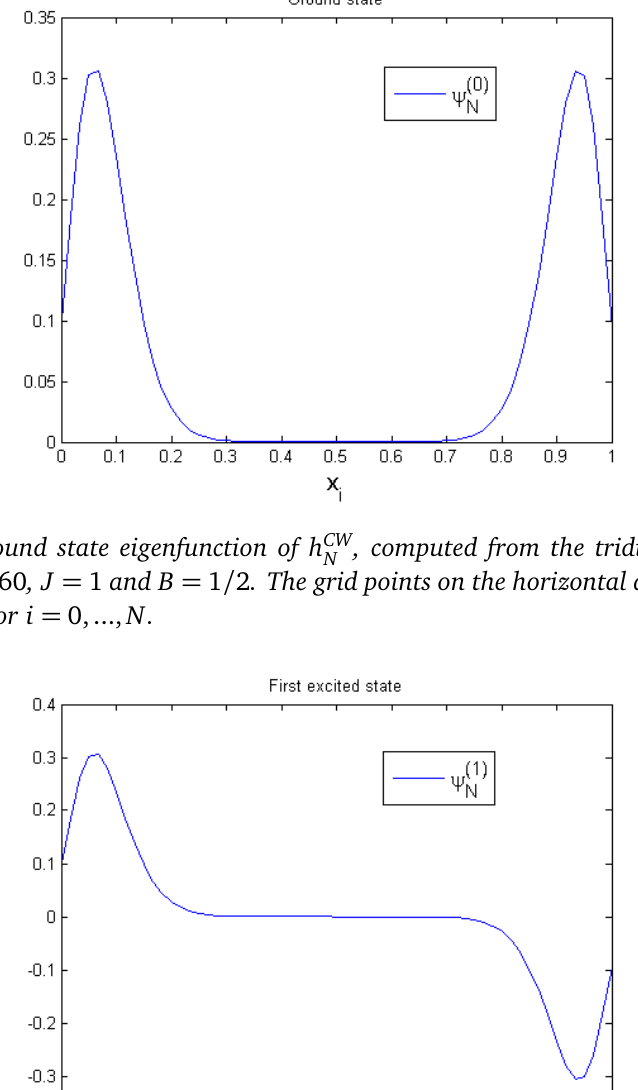
, computed from the tridiagonal matrix J N